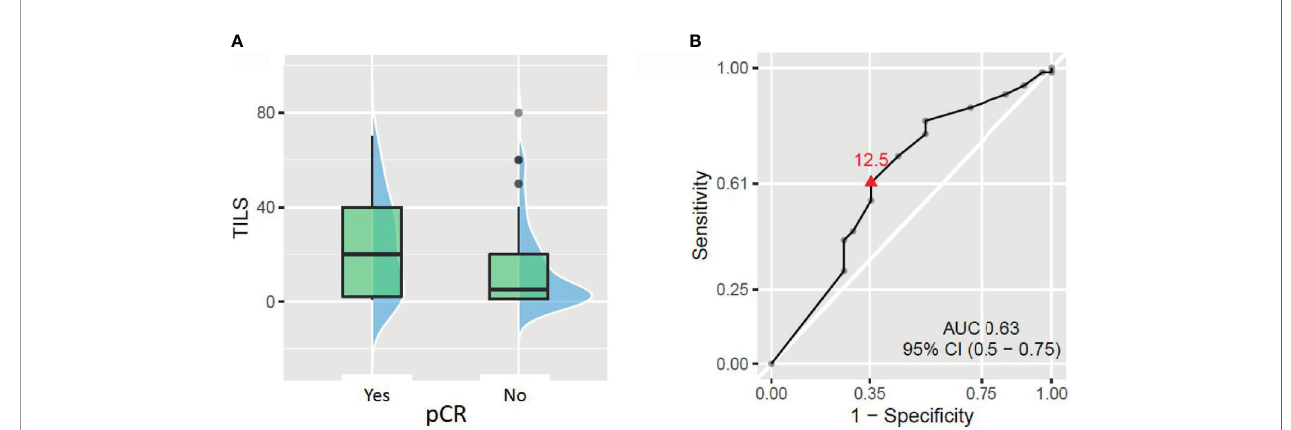
FIGURE 2 | Relationship between tumor-in fi ltrating lymphocytes (TILs) on biopsy and pathologic complete response (pCR). (A) Patients who achieved pCR had signi fi cantly higher baseline TILs (p = 0.043). (B) ROC curve showing the best TIL cut-off to predict patient chances to reach pCR (TIL considered as a continuous